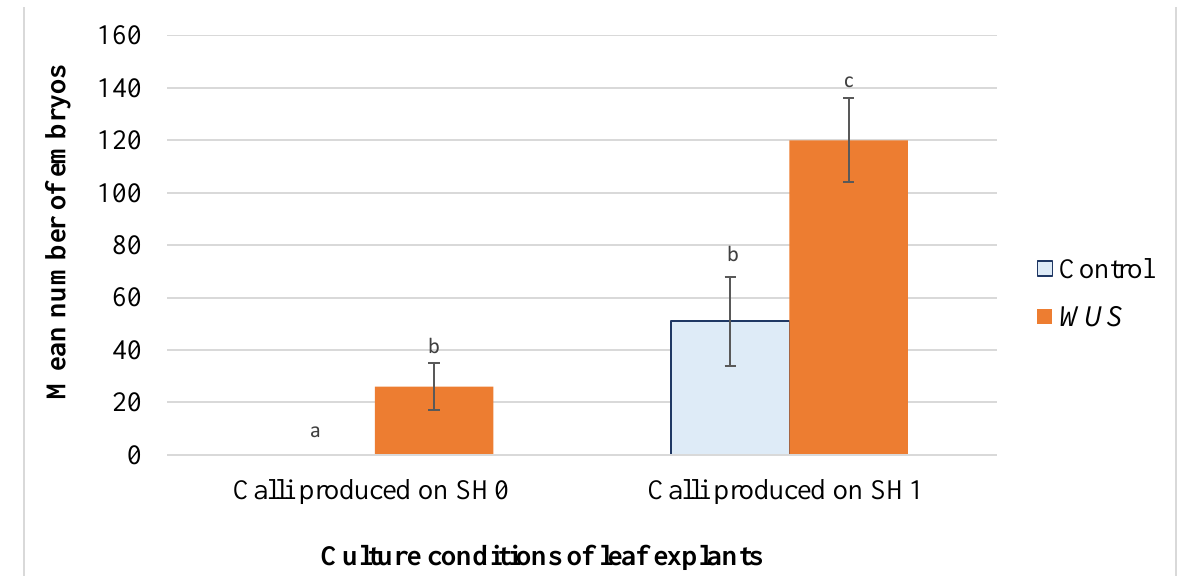
Figure 5. Embryo production from leaf explants of Medicago truncatula . Mean number of embryos produced on calli formed leaf explants of M. truncatula transformed using pCambia- BAR (Control) and pCambia1301- WUS-BAR l ( WUS ) cultured on SH2 (without growth regulators). These calli were produced on SH0 (without growth regulators) or on SH1 (4 mg · L − 1 2,4-D, 0.5 mg · L − 1 BAP). Data represent the mean ± standard errors of three replicates. Bars with different letters were significantly different at p < 0.05.